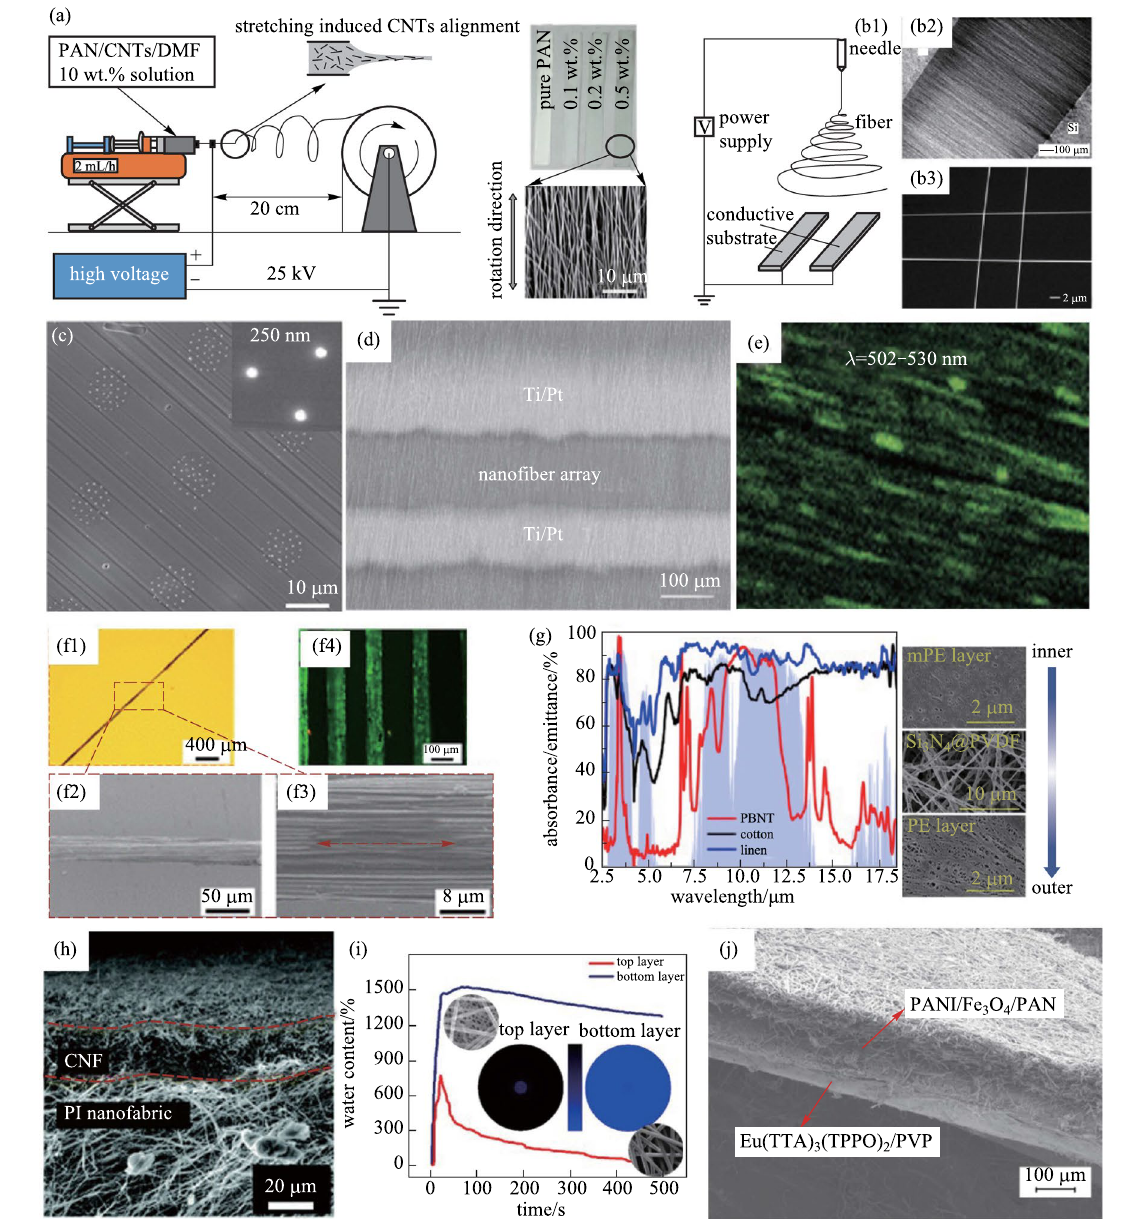
Fig. 6 a Electrospinning collection by a drum collector: experimental set-up and the obtained aligned PAN/CNTs nanofibers [115]. b (1) Sche- matic illustration of the set-up that used an electric field to align nanofiber arrays. The collector was composed of two conductive substrates sep- arated by a gap; (2) Dark-field optical micrograph of PVP nanofibers collected across the gap formed between two silicon strips; (3) SEM image of a 2 × 2 array of fibers [108]. c SEM image of the cross-section of indefinitely long uniform nanofiber arrays prepared by the hot drawing method [25]. d SEM images of NTO nanofiber array sensor between Ti/Pt electrode [114]. e Scanning probe fluorescence image shows quite a homogeneous distribution of green-emitting molecules [12]. f (1), (2), (3) are aligned NFYs and (4) is a fluorescent merged image of aligned and elongated C2C12 cells fully attached to the aligned NFYs core within the 3D hydrogel shell [51]. g Microstructure of the PBNT from the inner to outer surfaces and IR absorbance/emittance curves of the PBNT, cotton, and linen. The light blue area refers to the atmospheric transmittance